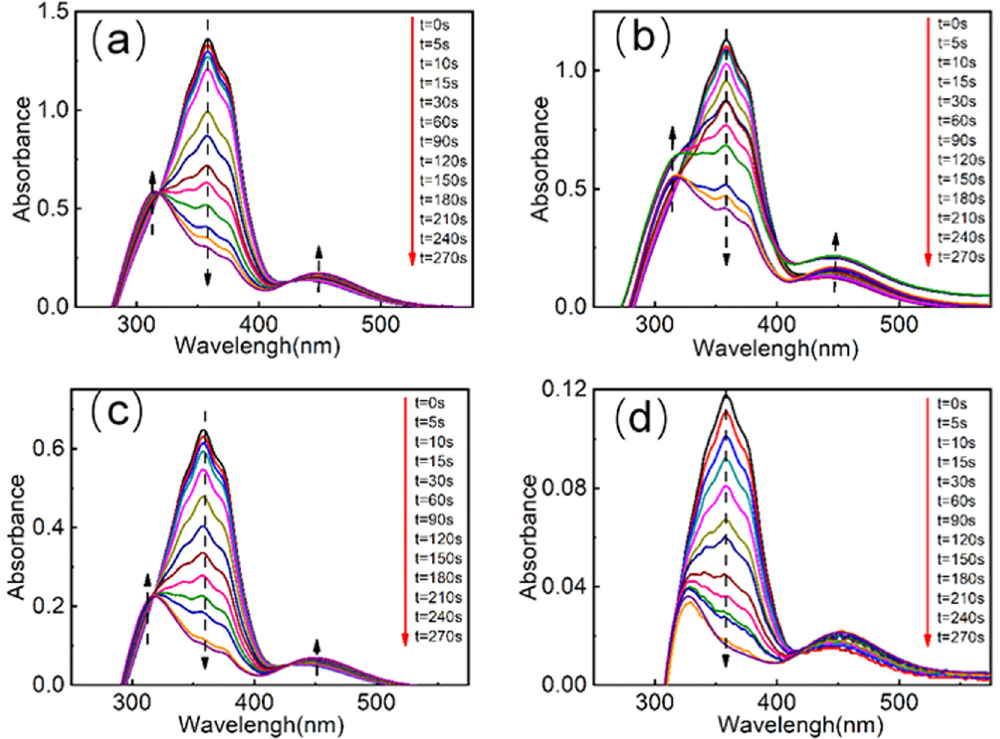
Figure 5: The UV - absorption of liquid crystalline polymer: ( a ) LCP, ( b ) LCP - POSS - 1, ( c ) LCP - POSS - 2, and ( d ) LCP - POSS - 3 at di ff erent times with UV